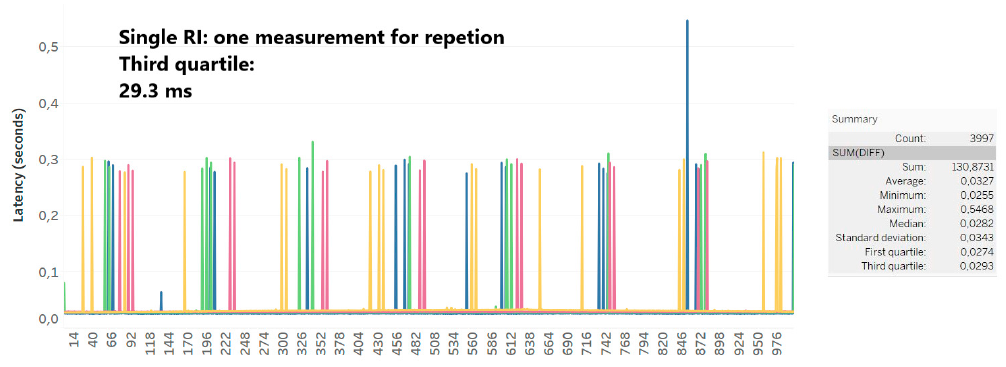
Figure 7. Single research infrastructure (RI) results for JaNDER Level 0 test: one single measurement for every repetition.